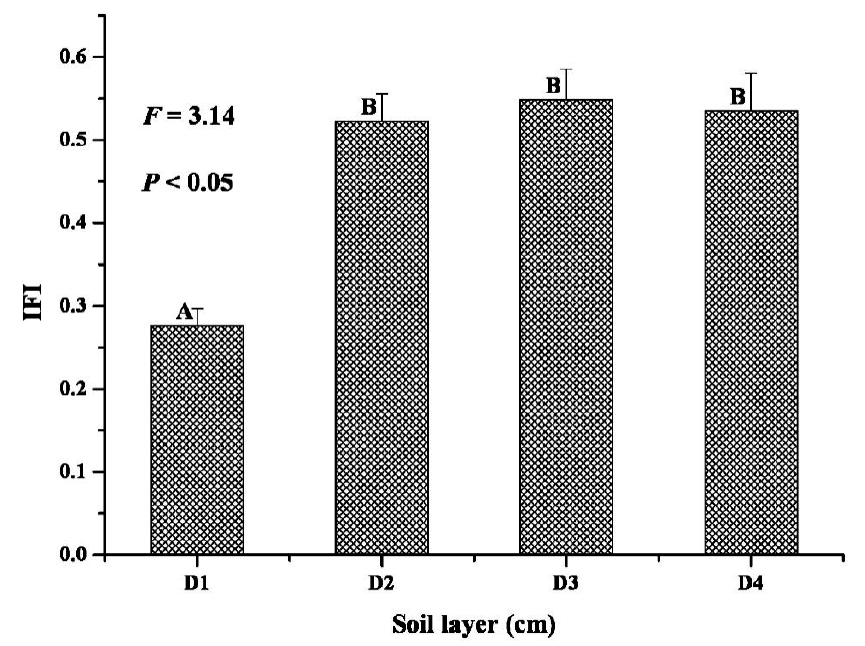
Figure 2. Soil fertility at different depths (D1, D2, D3, D4 refer to the different soil layer; A, B represents the result of a letter marker in a variety of comparisons).